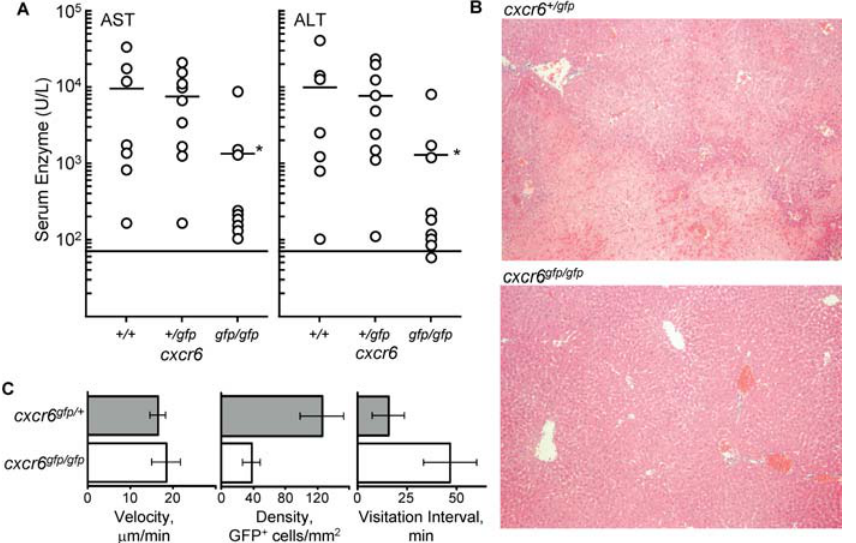
Figure 6. Decreased Patrolling Efficiency and Decreased ConA Hepatitis Severity in CXCR6-Deficient Mice (A) Serum transaminase levels in cxcr6 gfp/gfp , cxcr6 gfp/ þ , and cxcr6 þ / þ littermates 12 h after a challenge with 20 mg/kg ConA IP. Results are pooled from two independent experiments. The horizontal line represents the upper limit for normal serum transaminase levels, as measured in unchallenged mice. Asterisk indicates a two-tailed student’s t -test with a p , 0.05 in comparison with littermates. (B) Hematoxylin and eosin staining of paraffin-embedded liver sections from cxcr6 gfp/ þ and cxcr6 gfp/gfp mice sacrificed 12 h after a challenge with 20 mg/kg ConA IP. (C) Reduced sinusoid patrolling by NKT cells in cxcr6 gfp/gfp mice. By measuring the average inter-nuclei distance of hepatocytes in high- magnification images, the average sinusoidal length of a hepatocyte was determined to be 28.6 l m (data not shown). Utilizing the lymphocyte velocity data (left panel) and assuming that a CD1d-reactive T cell can contact only one hepatocyte at a time, we calculated that each CD1d- reactive T cell can visit 0.58 hepatocytes/min in the cxcr6 gfp/ þ mice, and 0.64 hepatocytes/min in the CXCR6-deficient mice. The density of GFP þ cellsin cxcr6 gfp/ þ and cxcr6 gfp/gfp mice(middlepanel)wascalculatedfromtheintravitalvideosusedinFigure3andtheflowcytometrydatainFigure2. Combining the similar crawling velocities with the different steady-state densities, we show decreased rate of patrolling by GFP þ lymphocytes, expressed as the average time between ‘‘ visitation ’’ of any single hepatocyte (right panel). DOI: 10.1371/journal.pbio.0030113.g006